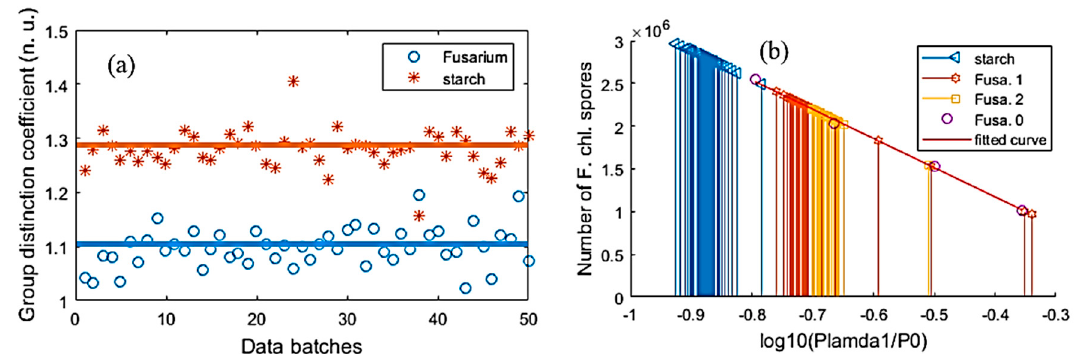
Figure 13. Using data of di ff erent Fusarium samples and starch sample measured by λ 1 thermopile. Figure 13. Using data of different Fusarium samples and starch sample measured by 𝜆 (cid:2869) thermopile. ( a ) η starch and η Fusarium and ( b ) the fitted curve of the known-in-advance Fusarium samples, the Figure 13. Using data of different Fusarium samples and starch sample measured by 𝜆 (cid:2869) thermopile. ( a ) 𝜂 (cid:3046)(cid:3047)(cid:3028)(cid:3045)(cid:3030)(cid:3035) and 𝜂 (cid:3007)(cid:3048)(cid:3046)(cid:3028)(cid:3045)(cid:3036)(cid:3048)(cid:3040) and ( b ) the fitted curve of the known-in-advance Fusarium samples, the interpolation and extrapolation of the unknown-di ff erent Fusarium and starch samples. * Fusa. 0 stands ( a ) 𝜂 (cid:3046)(cid:3047)(cid:3028)(cid:3045)(cid:3030)(cid:3035) and 𝜂 (cid:3007)(cid:3048)(cid:3046)(cid:3028)(cid:3045)(cid:3036)(cid:3048)(cid:3040) and ( b ) the fitted curve of the known-in-advance Fusarium samples, the interpolation and extrapolation of the unknown-different Fusarium and starch samples. * Fusa. 0 for the known-in-advance Fusarium sample. Fusa. 1 and Fusa. 2 are two unknown-quantity samples. interpolation and extrapolation of the unknown-different Fusarium and starch samples. * Fusa. 0 stands for the known-in-advance Fusarium sample. Fusa. 1 and Fusa. 2 are two unknown-quantity stands for the known-in-advance Fusarium sample. Fusa. 1 and Fusa. 2 are two unknown-quantity samples. samples. Table 4. Group distinction coe ffi Table 4. Group distinction coefficient. Table 4. Group distinction coefficient.